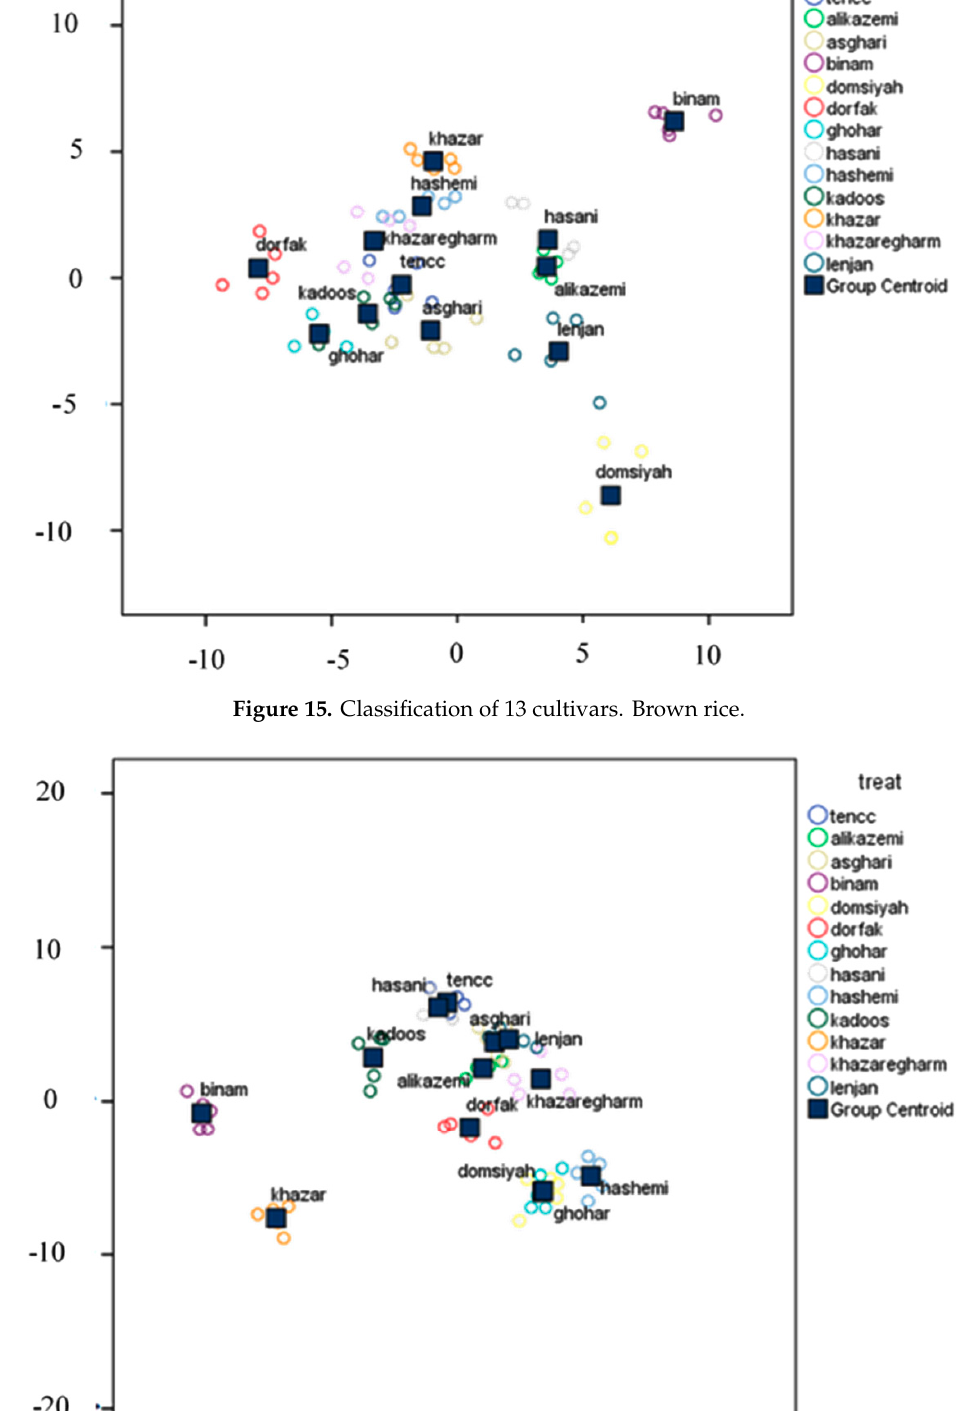
Figure 17. Classification of 13 white rice cultivars using linear DA.